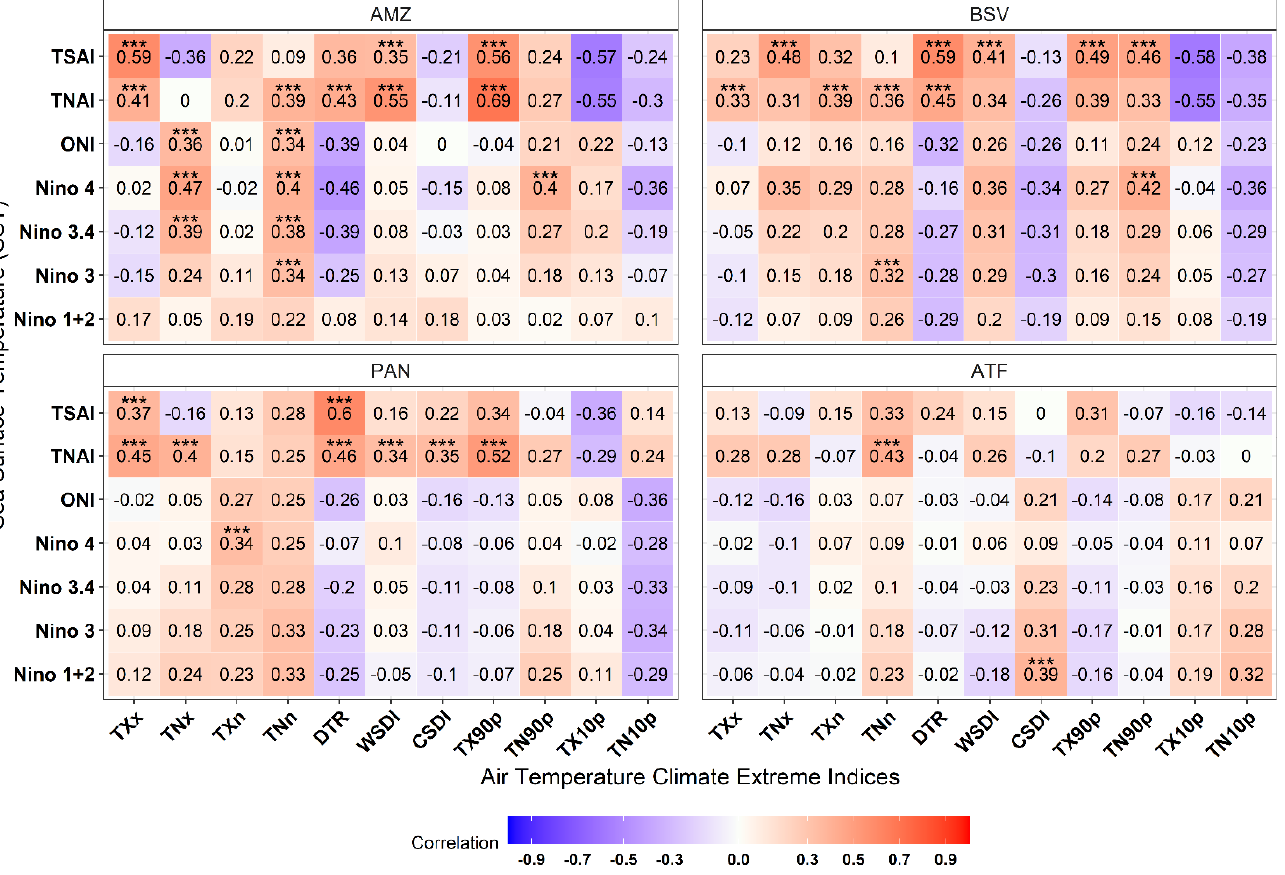
Figure 7. Pearson’s correlation coefficients of Sea Surface Temperature (SST) anomalies with air temperature climate extreme indices in the Amazon (AMZ), Brazilian Savanna (BSV), Pantanal (PAN), and Atlantic Forest (ATF) in the Brazilian Midwest from 1979 to 2019. Cells with *** indicate p ‐ value < 0.05.